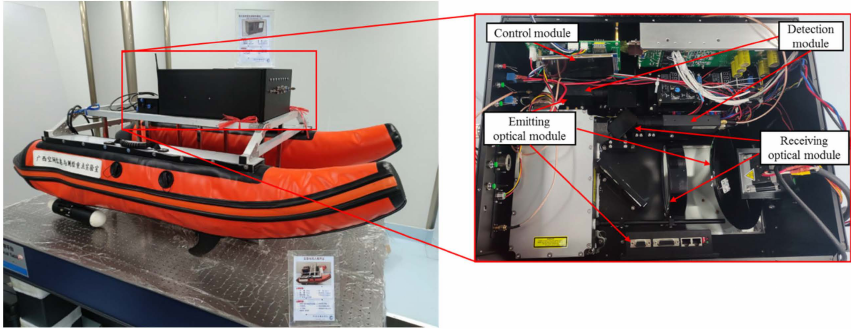
Figure 17. LiDAR overall physical